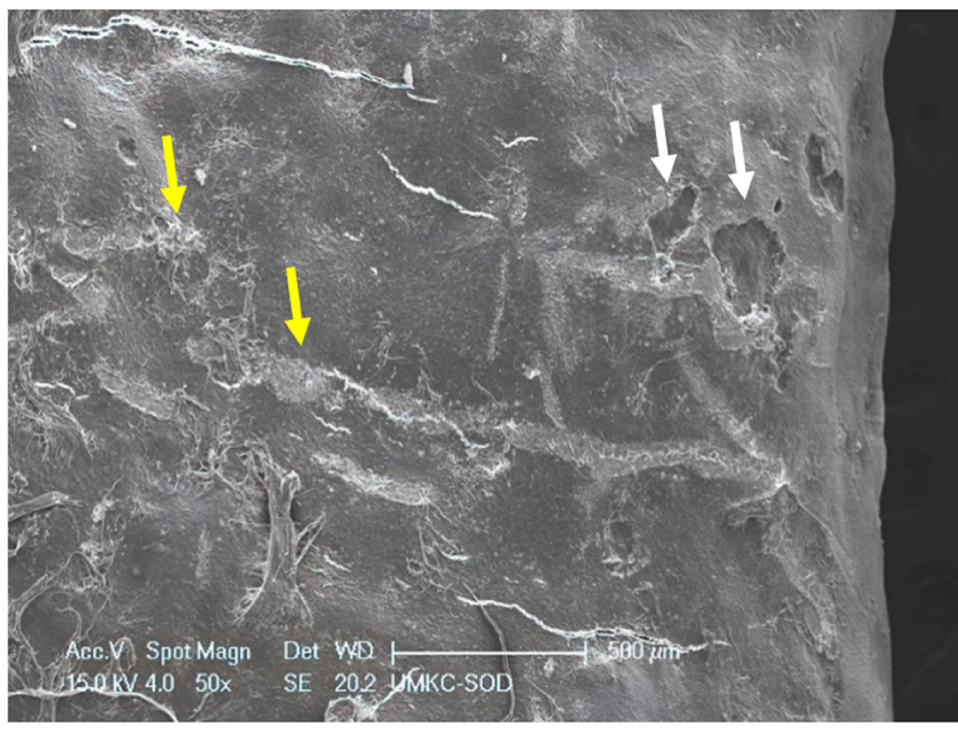
Figure 1. SRP-only treated specimen exhibiting deposits of calculus ( yellow arrows ) and several cavitation-like defects in root surface ( white arrows ). Original magnification of 40×; Bar = 500 μ m.